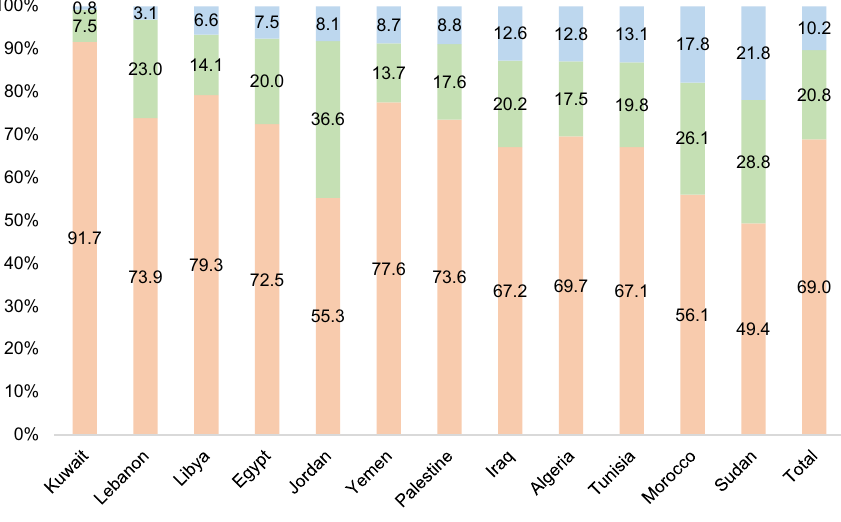
Fig. 2 Distribution of desire to emigrate and willingness to do so without papers by country, 2018/19. Notes: Arab Barometer, 2018/19. Weighted. See Fig. 1 for question on desire to emigrate. Those who responded “yes” were then asked “Would you consider leaving [COUNTRY] even if you didn’t have the required papers that officially allowed you to leave?”. “Total” figure country-level